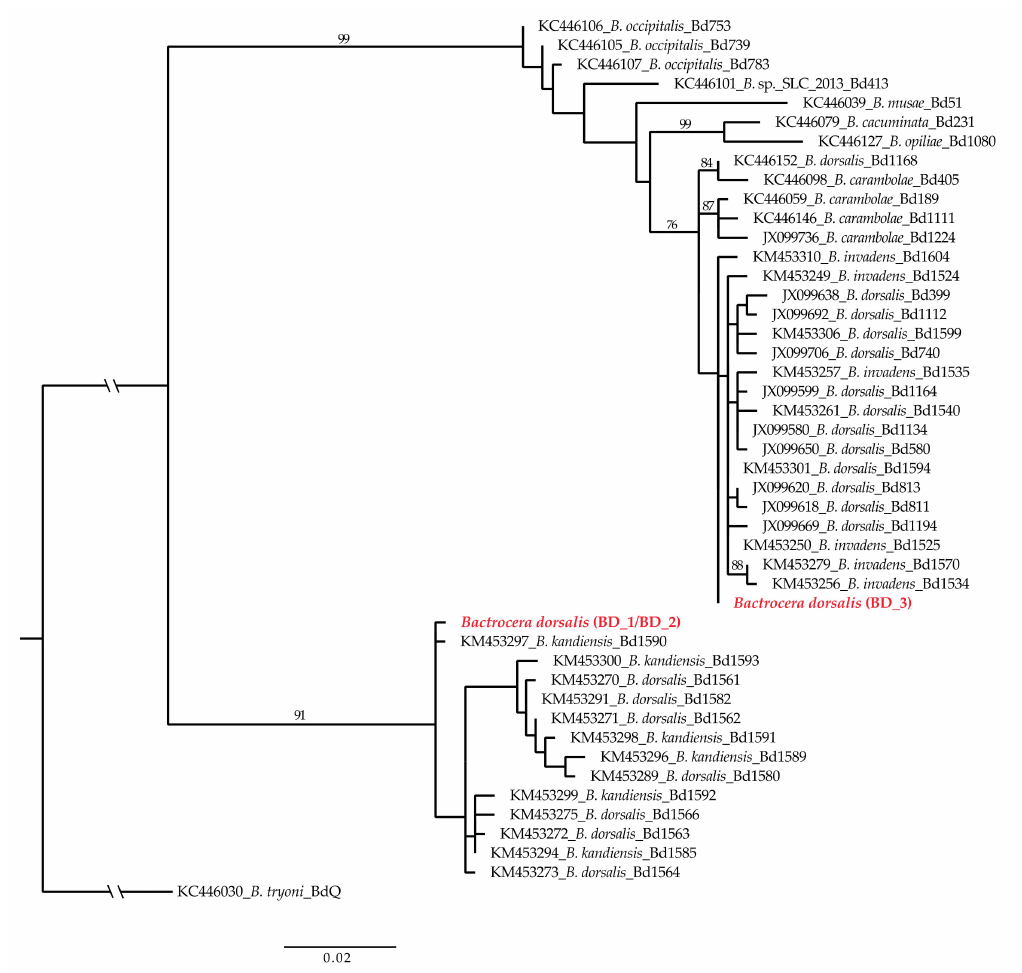
Figure 3. Maximum likelihood consensus tree for the mitochondrial portion dataset COI-A of the Bactrocera species selected from Schutze et al. [13]. Bootstrap values of >70% are shown above